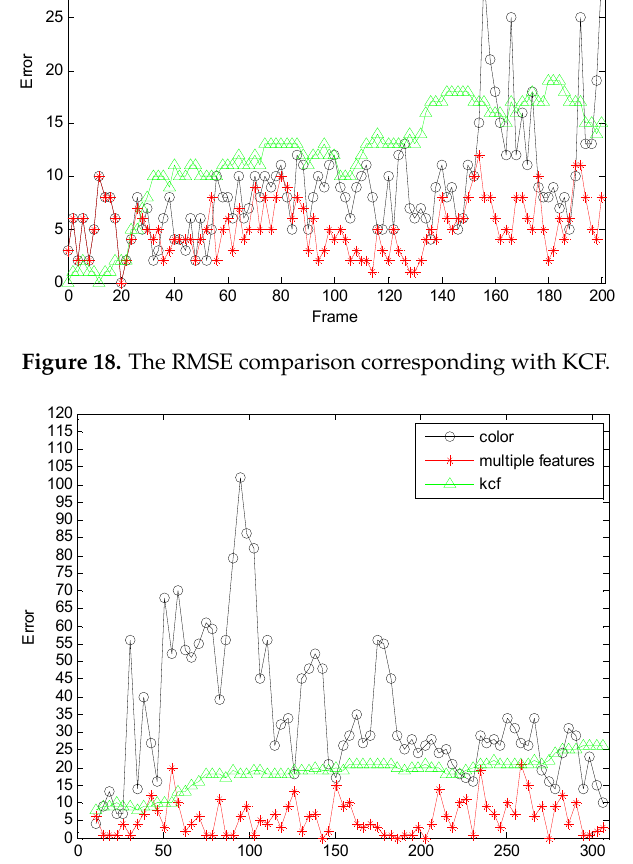
Figure 20. The RMSE comparison corresponding with Fisherface.